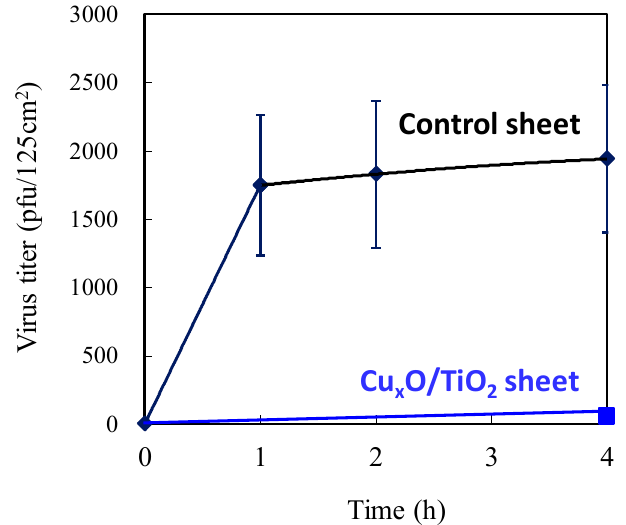
Figure 17. Antiviral properties of the Cu x O / TiO 2 -coated sheet and the control sheet without the photocatalyst using splash-containing bacteriophage Q β . In the case of Cu x O / TiO 2 to avoid the overestimation of its antiviral property, the number of experiments was set to 1 time (after 4h) in order to exclude the influence of air flow due to human’s entering into the room for measurement.